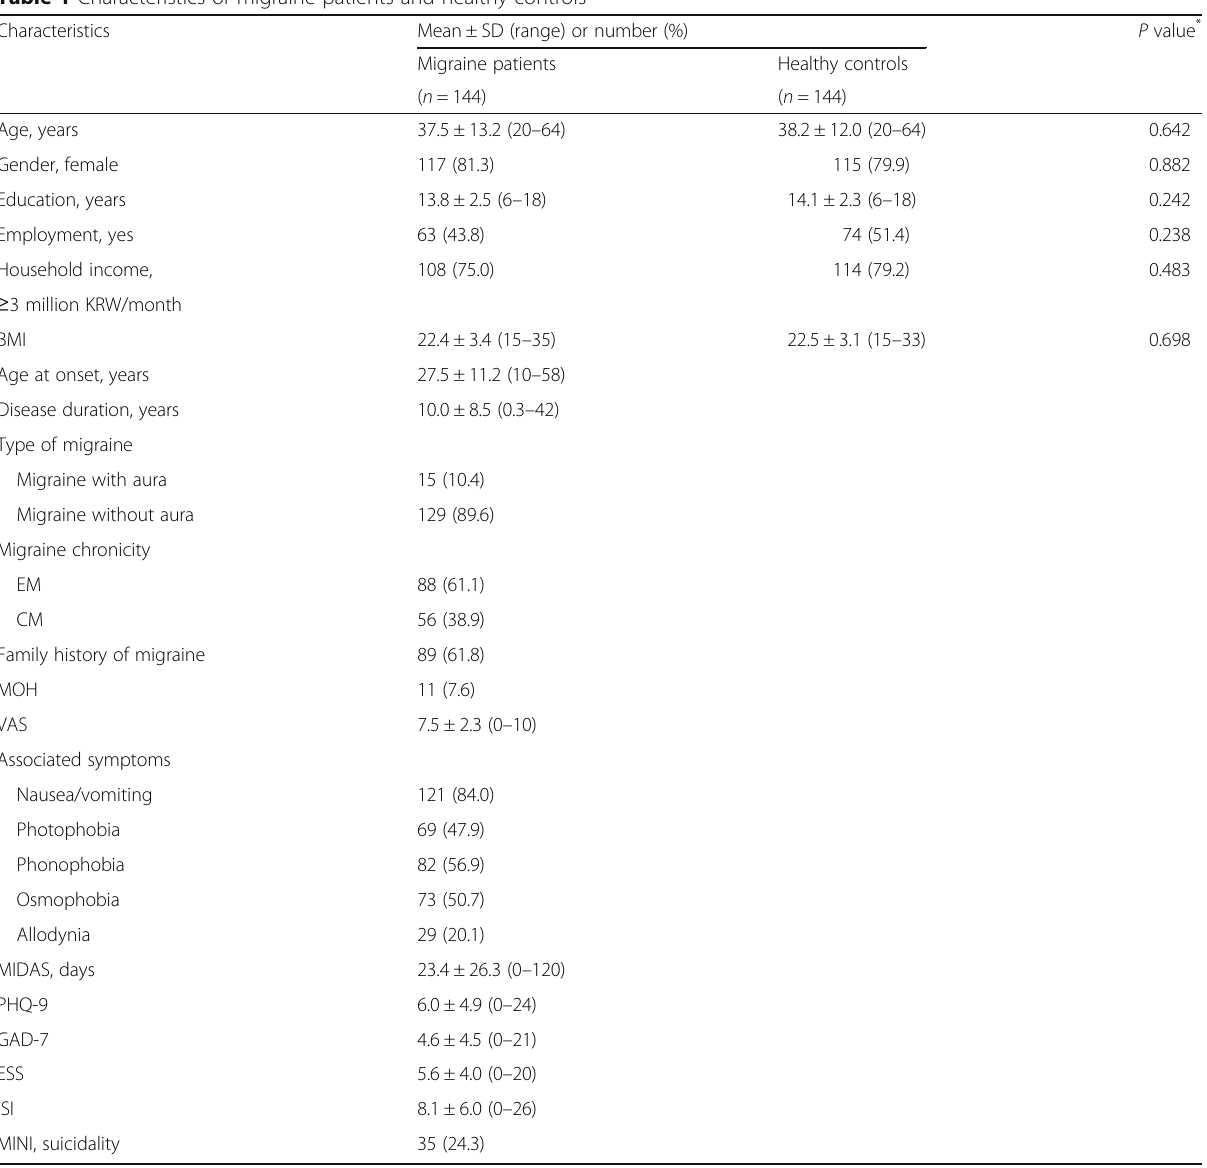
Table 1 Characteristics of migraine patients and healthy controls